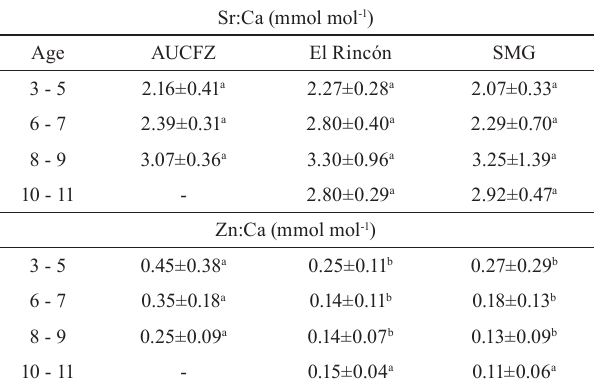
Table 3. Otolith Sr:Ca and Zn:Ca ratios (mean±standard deviation) for Percophis brasiliensis from the Argentine- Uruguayan Common Fishing Zone (AUCFZ), El Rincón (ER) and San Matías Gulf (SMG), within each age group. Different letters indicate statistical significance among sampling sites for each age group (p<0.05).